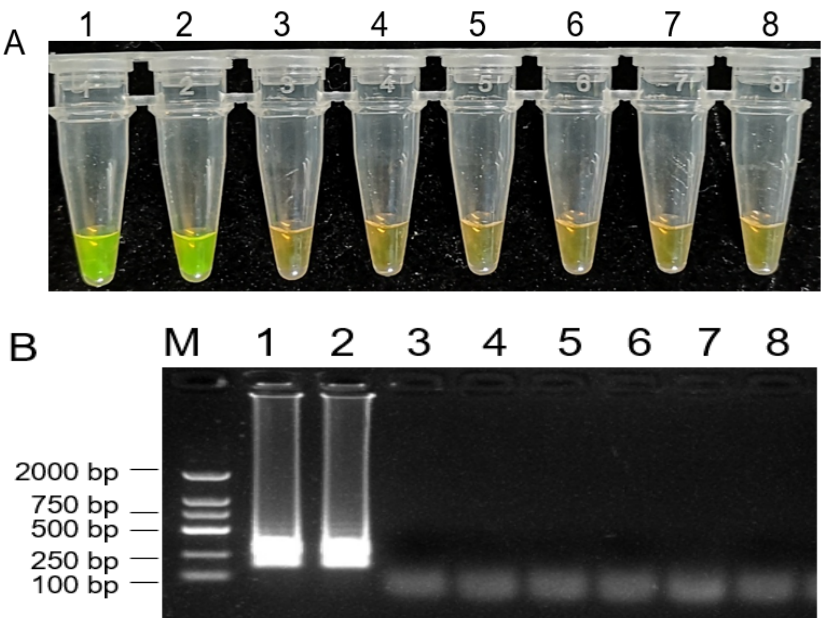
Figure 5. Loop-mediated isothermal amplification (LAMP) assay on detection of Botryosphaeria dothidea . 1000 × SYBR Green I color change-based LAMP product detection ( A ). Agarose gel electrophoresis-based LAMP product detection ( B ). M: DNA marker 2 k, 1: Botryosphaeria dothidea isolate from kiwifruit fruit, 2: Botryosphaeria dothidea isolate from kiwifruit stem, 3: Botrytis cinerea , 4: Colletotrichum gloeosporioides , 5: Valsa mali , 6: Alternaria alternate , 7: Marssonina coronaria , 8: water.